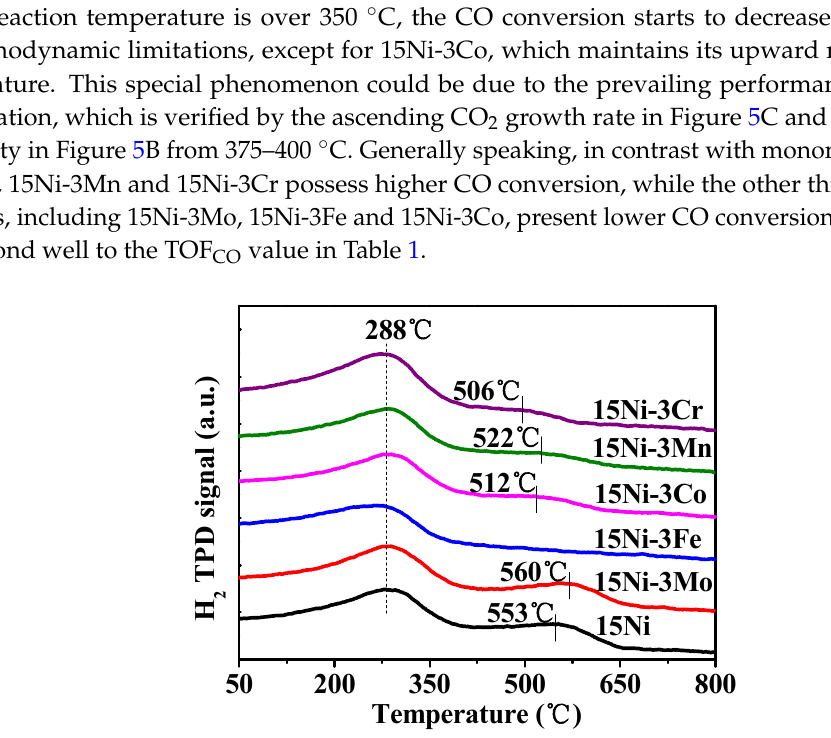
Figure 4. H 2 ‐ TPD curves of the reduced catalysts. Figure 4. H 2 -TPD curves of the reduced